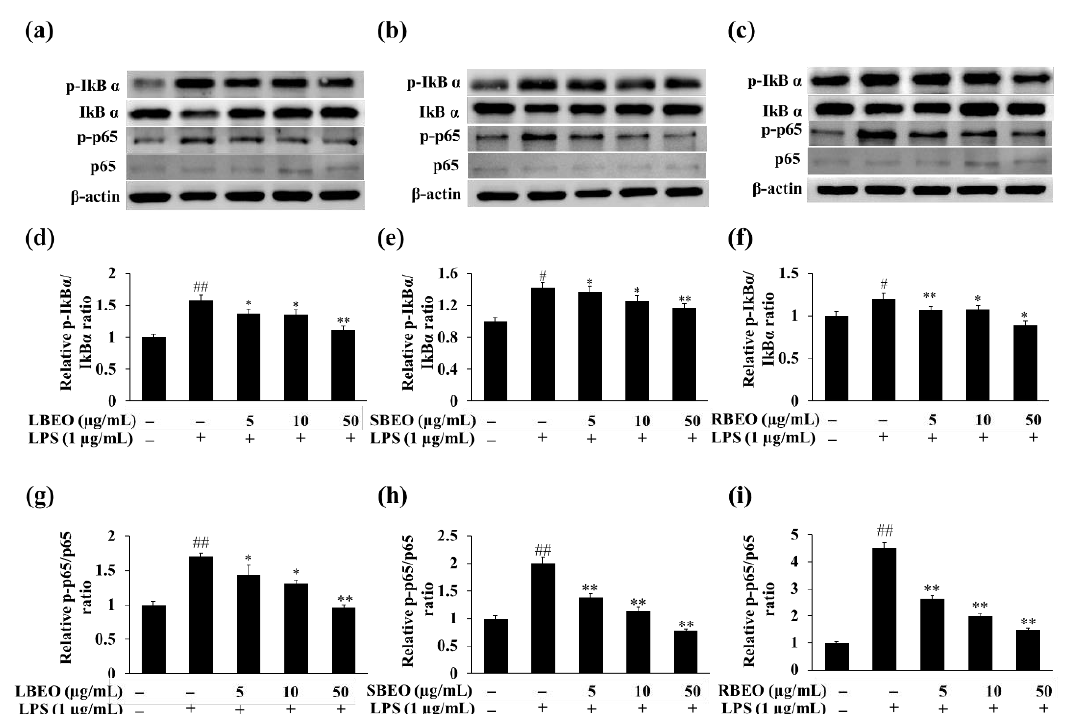
Figure 7. Effects of LBEO, SBEO, and RBEO on protein levels of I κ B α , p-I κ B α , p65, and p-p65 in RAW 264.7 macrophages. Western blot analysis of non-phosphorylated and phosphorylated forms of I κ B α and p65 in LPS-induced macrophages treated with ( a ) LBEO, ( b ) SBEO, and ( c ) RBEO. Relative expression level of p-I κ B α and p-p65 in ( d , g ) LBEO-, ( e , h ) SBEO-, and ( f , i ) RBEO-treated group compared to non-stimulated group. The results are expressed relative to those for the LPS-untreated cells as mean ± SD ( n = 3). # p < 0.05, and ## p < 0.01 vs. the LPS-untreated cells; * p < 0.05, and ** p < 0.01 relative to the LPS alone-treated cells.